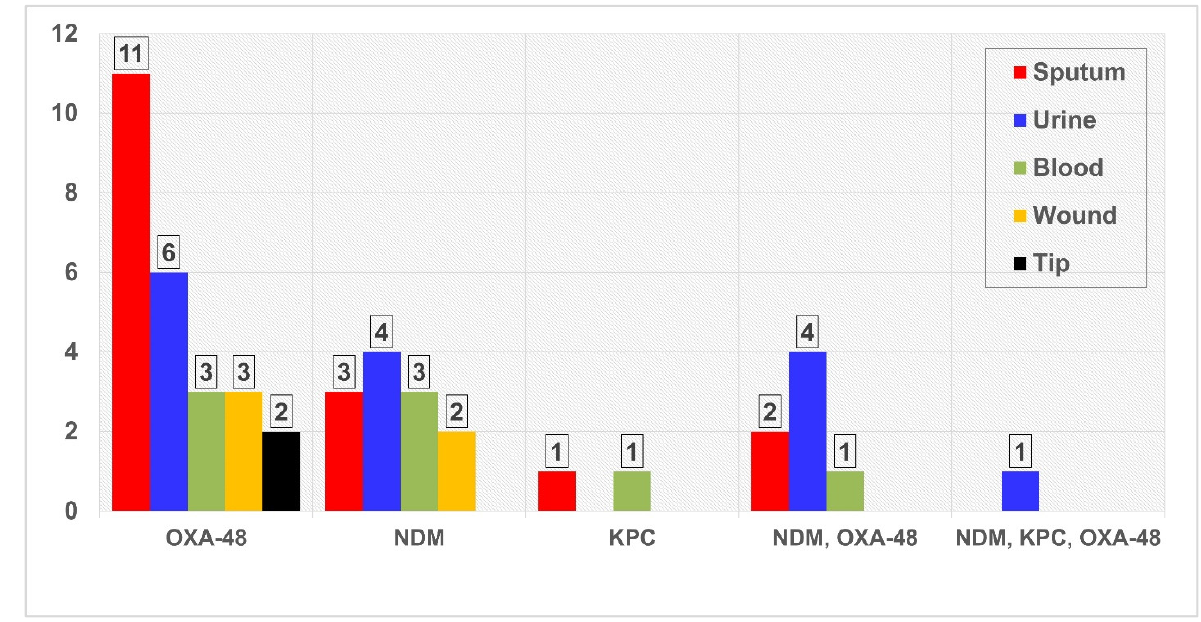
Figure 2. Distribution of carbapenemase-producing MDR. Klebsiella pneumoniae based on the types of clinical specimens.